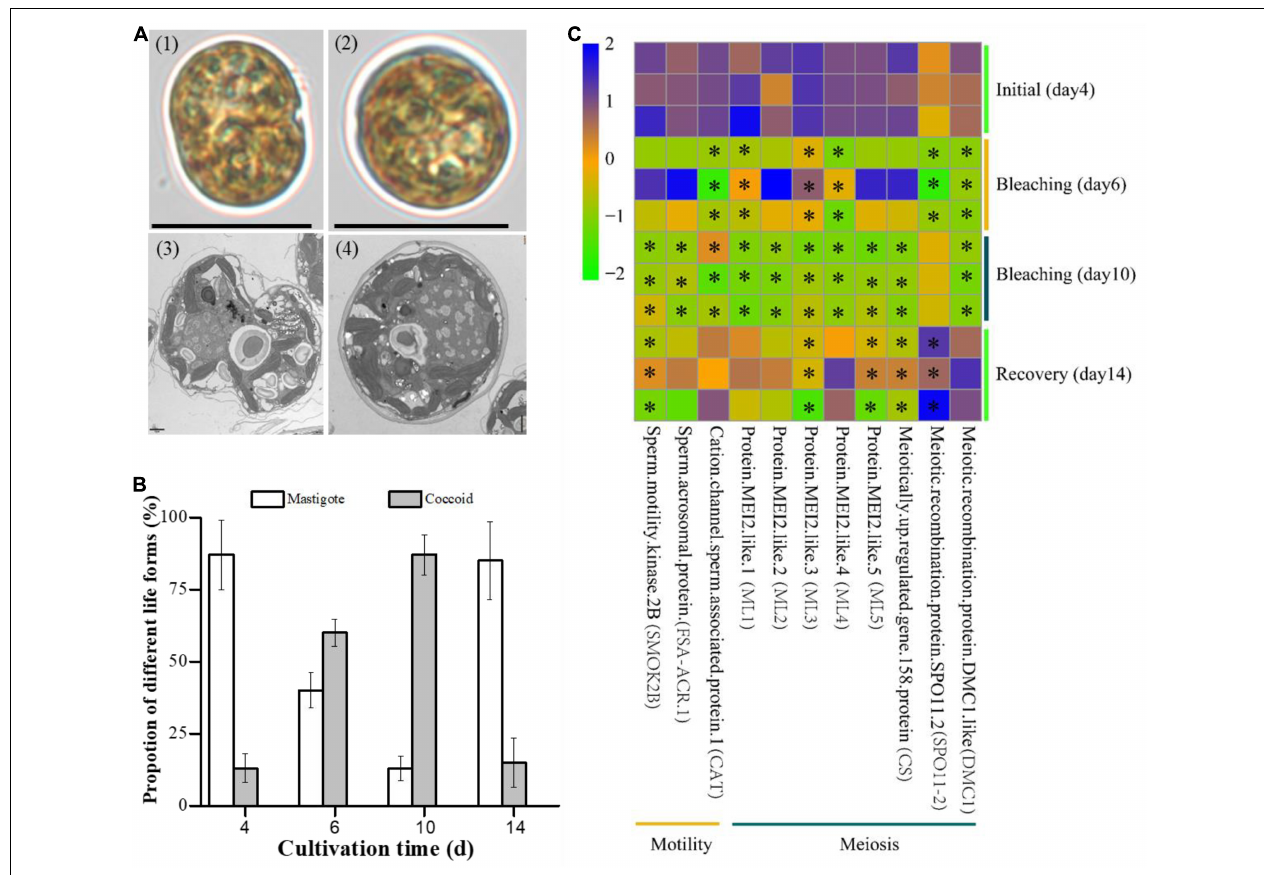
FIGURE 3 | The life forms of E. voratum SCS01 and genes related to these life forms during the photobleaching and recovery experiment. (A) Representative micrographs under bright-field conditions (top) and transmission electron micrographs (bottom) of the two major life forms observed in E. voratum SCS01 cells [1- and 3-mastigote cells (flagellated) and 2- and 4-coccoid cells (vegetative)]. (B) The proportions of mastigote cells and coccoid cells on day 4 (26 ◦ C, initial period), day 6 (32 ◦ C, bleached period), day 10 (32 ◦ C, bleached period), and day 14 (26 ◦ C, recovery period). (C) Pheatmap of differentially transcribed genes possibly related to life form formation. The pheatmap was drawn based on the FPKM values of differentially transcribed genes on day 4 (26 ◦ C, initial period), day 6 (32 ◦ C, bleached period), day 10 (32 ◦ C, bleached period), and day 14 (26 ◦ C, recovery period). Asterisks indicate significantly transcribed genes in the bleached period or recovery period vs. the initial period ( q -value <